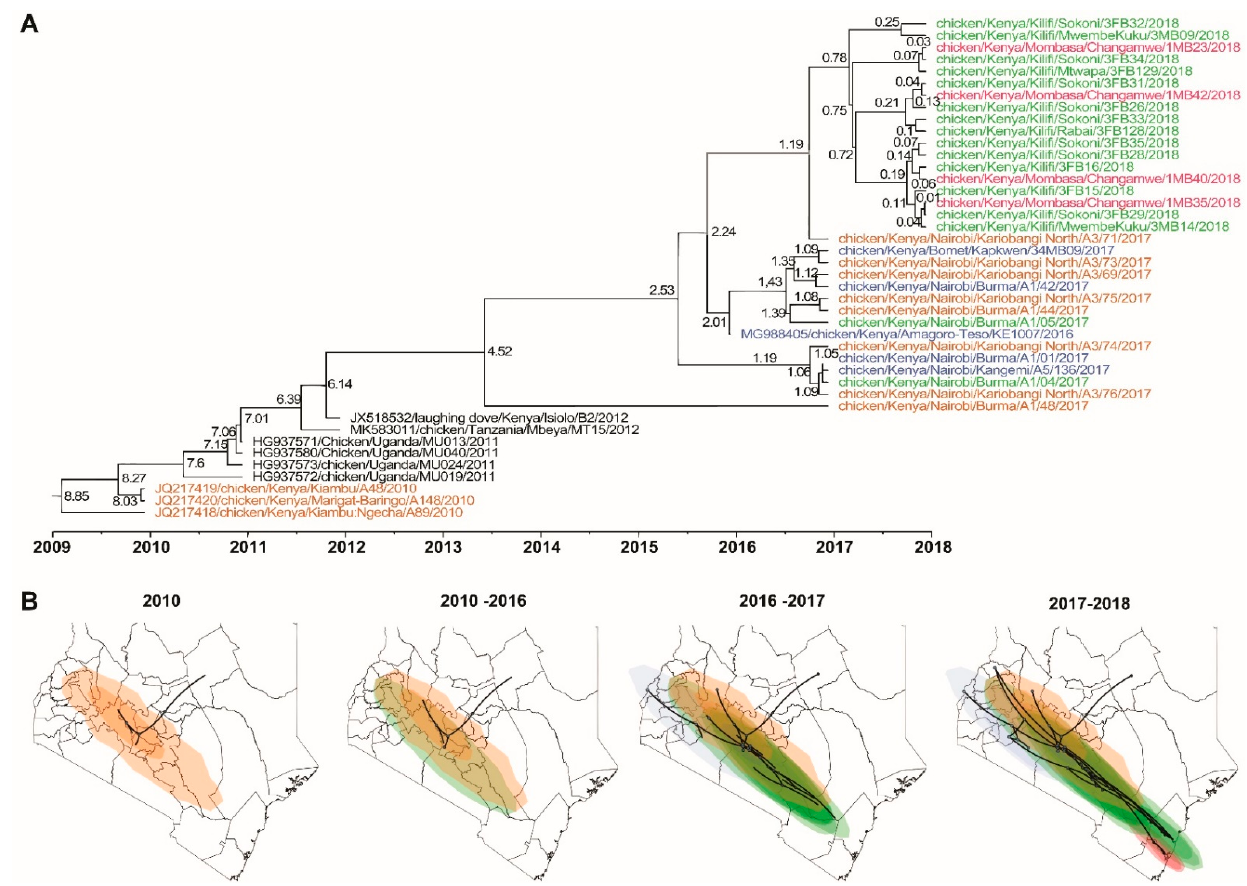
Figure 4. ( A ) Time-scaled phylogeographic relationships between the NDV isolates in east African region, and ( B ) a west-to-east spatial-temporal dispersal of the NDV genotype V.3 isolates between 2010 and 2018 in Kenya. The analyses were performed based on the nucleotide sequences of the NDV F-gene and included the 32 Kenyan isolates sequenced in the current study and previously sequenced isolates reported between 2010 and 2016. The numbers on the phylogeographic tree nodes (panel A ) represent tip height (from the oldest to the youngest isolate). Note that the isolates are color-coded depending on the sources of the chickens from which they were isolated (see a magnified map in Figure S4).